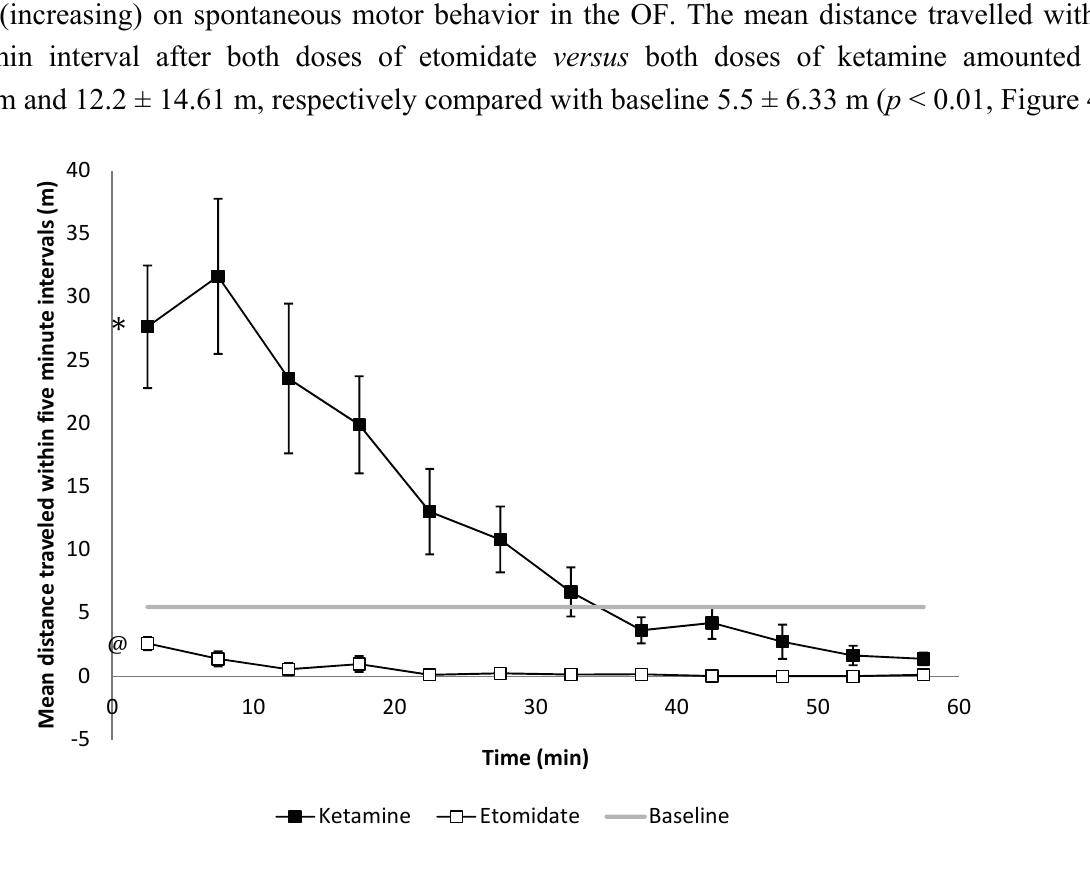
Figure 4. Motor function as assessed by spontaneous travel behavior in the open field evaluated within 5-min intervals. After 20 and 40 mg/kg of ketamine treatment, rats travel significantly longer distances compared to baseline (* p < 0.001 the slope of the distance travelled compared to the baseline, n = 6), while 2 and 4 mg/kg of etomidate anesthetized rats travel significant shorter distances within every 5-minute interval compared to the baseline (@ p = 0.009, n = 6). Error bars represent the